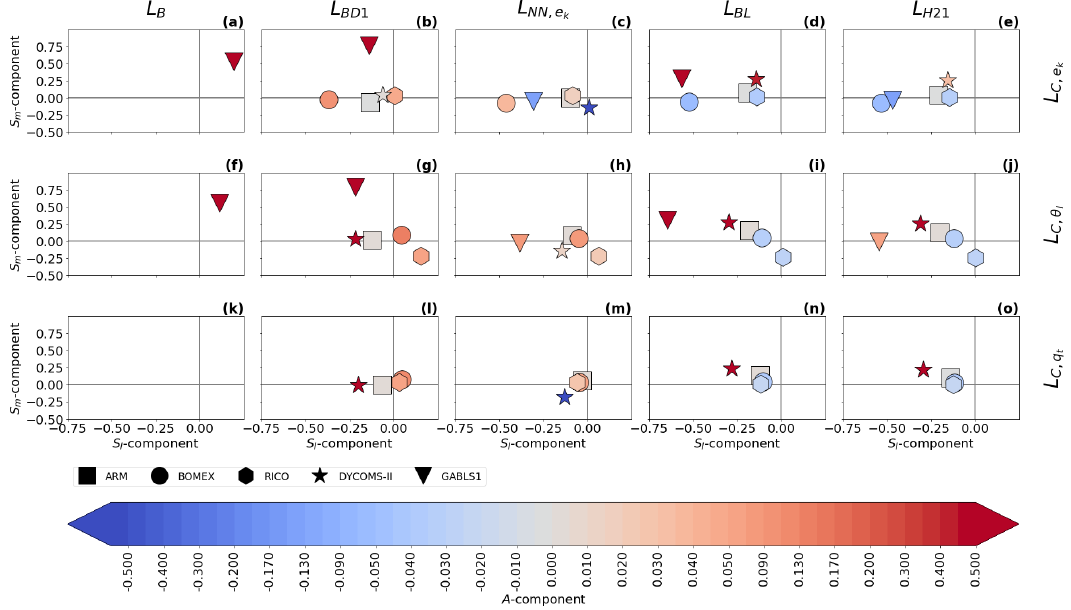
Figure 9. The differences in the time averaged normalized magnitude, S m , and height/location, S l , of the ABL peak (see Equations (41) and (42)) between the turbulence length scale formulations: L B , L BD 1 , L NN , e , L NN , q , L BL , and L H 21 (columns); and the turbulence length scale diagnostics (rows; t k L C , e : ( a – e ), L C , q : ( f – j ), L C , θ : ( k – o )). The symbols represent the evaluation for each of the boundary t k l layer cases, while the colors represent the time-averaged amplitude component, A (see Equation (39)). The scores are calculated for the second largest sub-domain size ( N sd = 2 2 ).